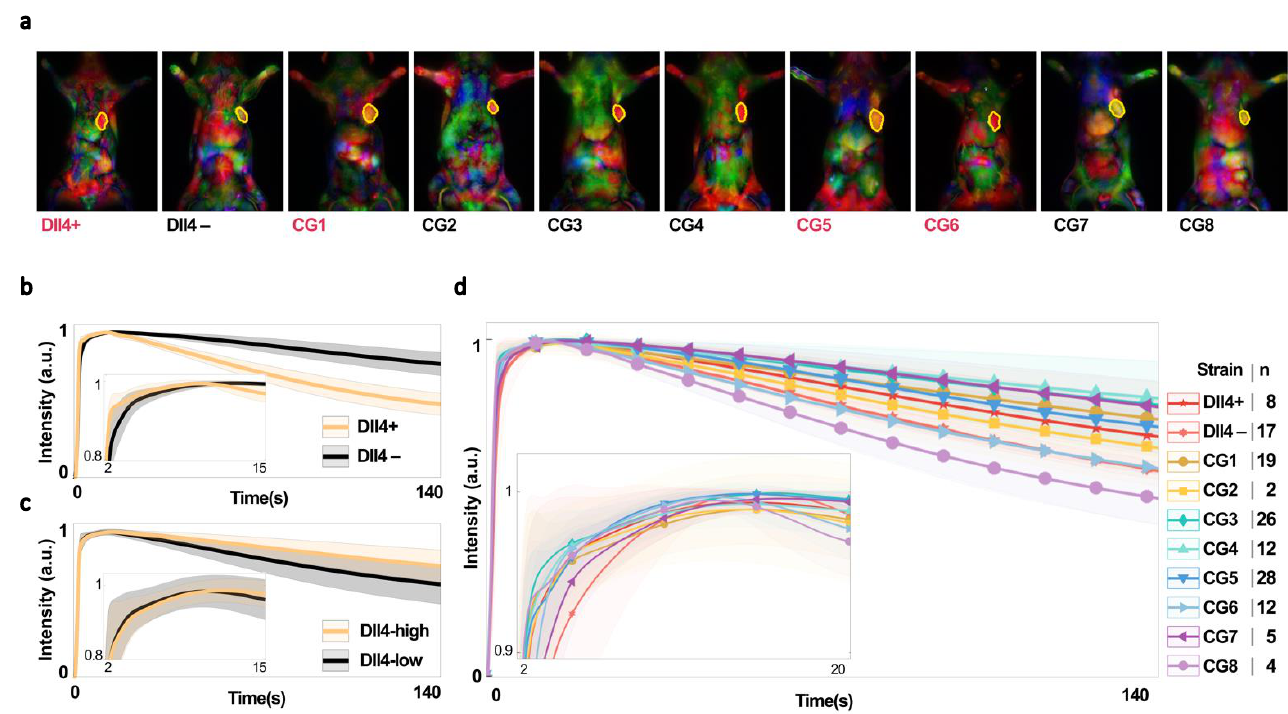
Figure 4. ( a ) Color-coded and merged principal component images were used to anatomically segment tumors from a single view/projection for rat strains with high (red) or low (black) levels of Dll4 expression. The top 3 ranked PCs for detecting tumors are merged as red, green, and blue channels of a true color (RGB) image. Tumors are outlined in yellow. ( b – d ) Mean intensity of ICG biodistribution fluorescence kinetic data over 140 s for ( b ) parental (Dll4+) and consomic (Dll4−) rats, ( c ) all Dll4−high and Dll4−low rats, and ( d ) all strains, plotted and normalized to a range of 0 to 1. Shaded regions show s.e.m.